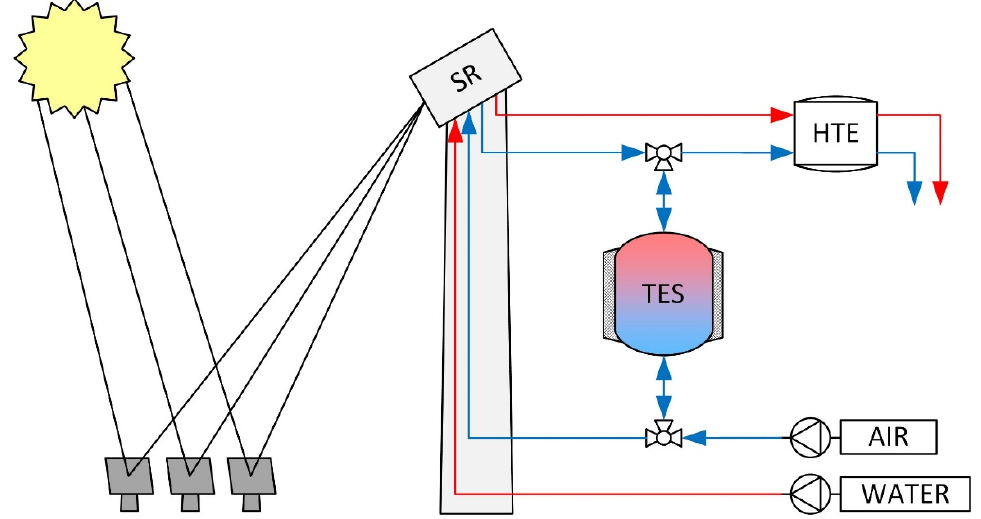
Figure 1. Simplified schematic CSP process layout without showing heat recuperation of the high- temperature electrolysis exit streams. Red and blue lines show the water/steam and air path, respec- tively.